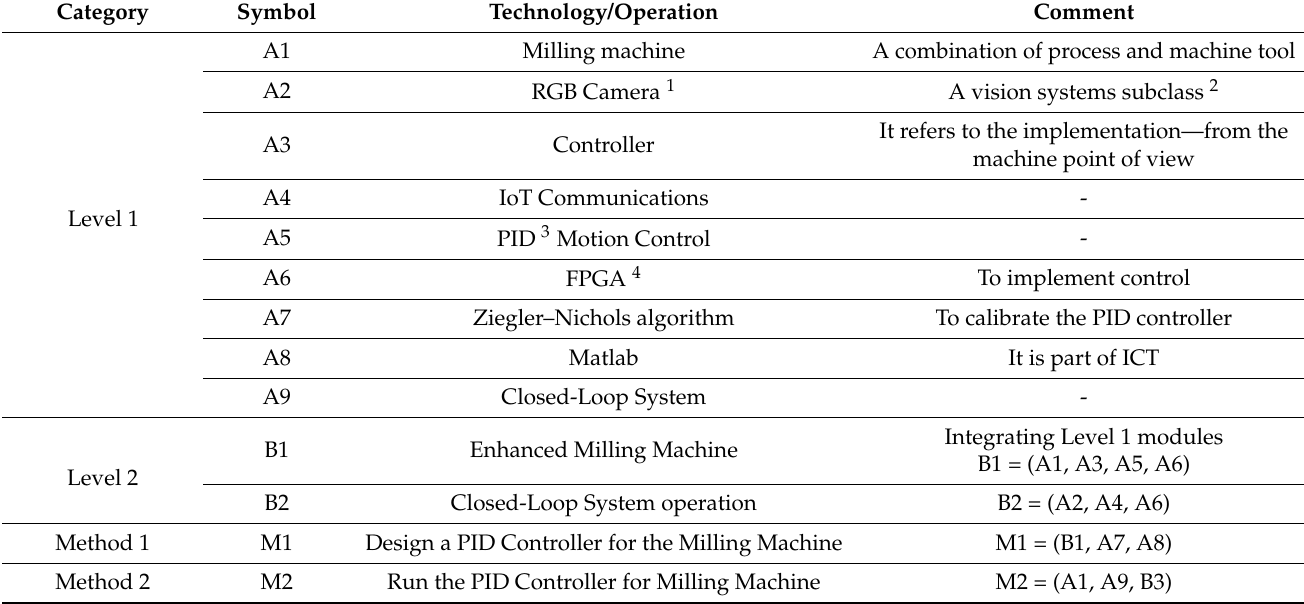
Table 1. Indicative ontology towards workflow definition.